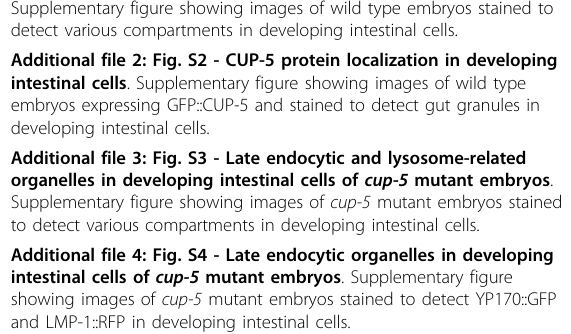
Abbreviations LRO: Lysosome-related organelle; MLIV: Mucolipidosis type IV; ABC: ATP- Binding